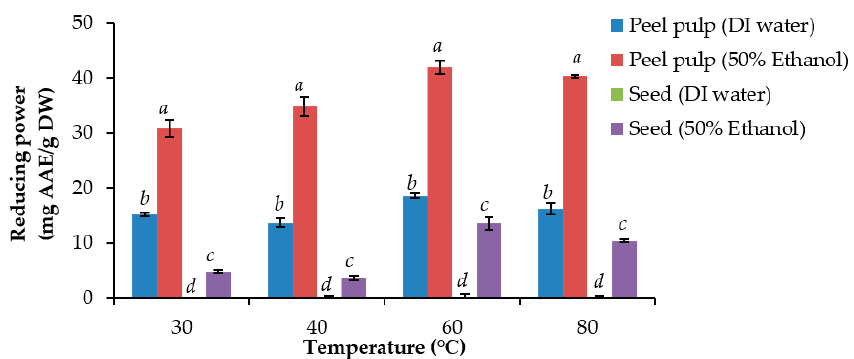
Figure 7. Reducing power of jujube peel pulp and seeds extracted with DI water and 50% ethanol at different temperatures. The error bar represents the standard error of the mean. The temperatures in the histogram with the same letter were not significantly different at the 5% level, according to the LSD test.